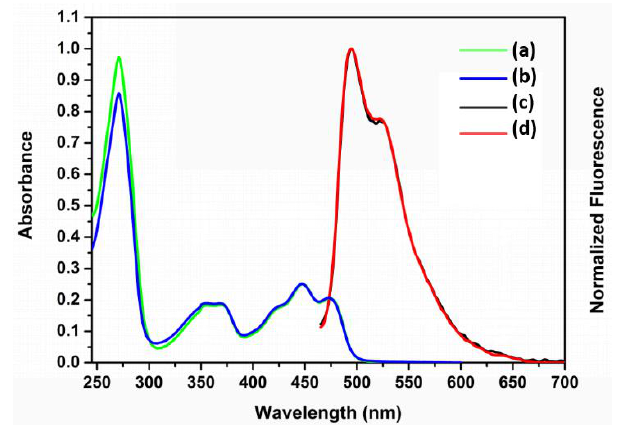
Figure 2. Absorption ( a , b ) and emission ( c , d ) spectra of iLOV and iLOV-W83A proteins.